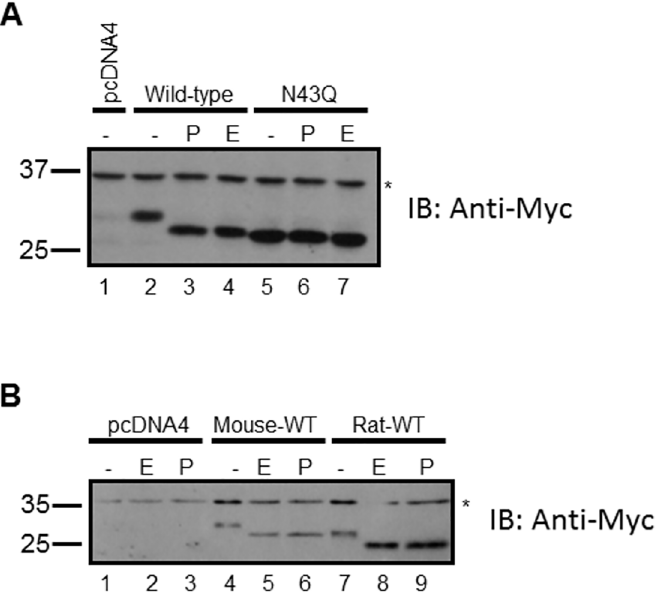
Fig 1. Murine and rat IGSF1-2 are glycoproteins. A) CHO cells were transfected with empty vector (pcDNA4), wild-type murineIGSF1-2-Myc/His, or murine IGSF1-2 (N43Q)-Myc/His expressionvectors. Whole cell protein lysates were collected and treated with PNGaseF (P), EndoH(E), or buffer alone (-) before being subjectedto SDS-PAGE and immunoblotting (IB) with a Myc antibody. Molecularweight markers (in kDa) are shown at the left. Lanes are numbered at the bottom. B) CHO cells were transfected and lysates analyzedas in panel A, with the followingexception:wild-typerat IGSF1-2-Myc/His was used in place of the mutant murine expressionvector. * ,